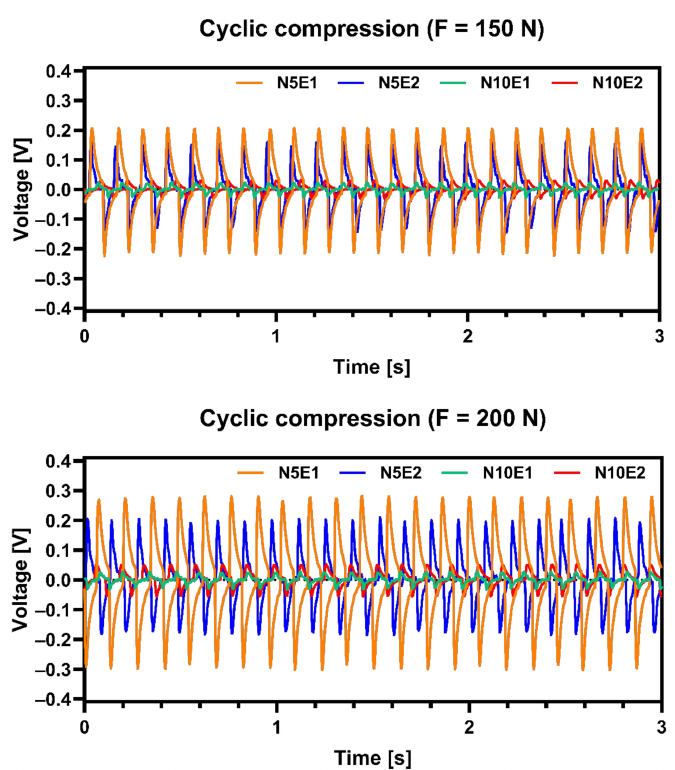
Figure 8. Signal generated by obtained samples under cyclic compression of 150 N ( above ) and 200 N ( below